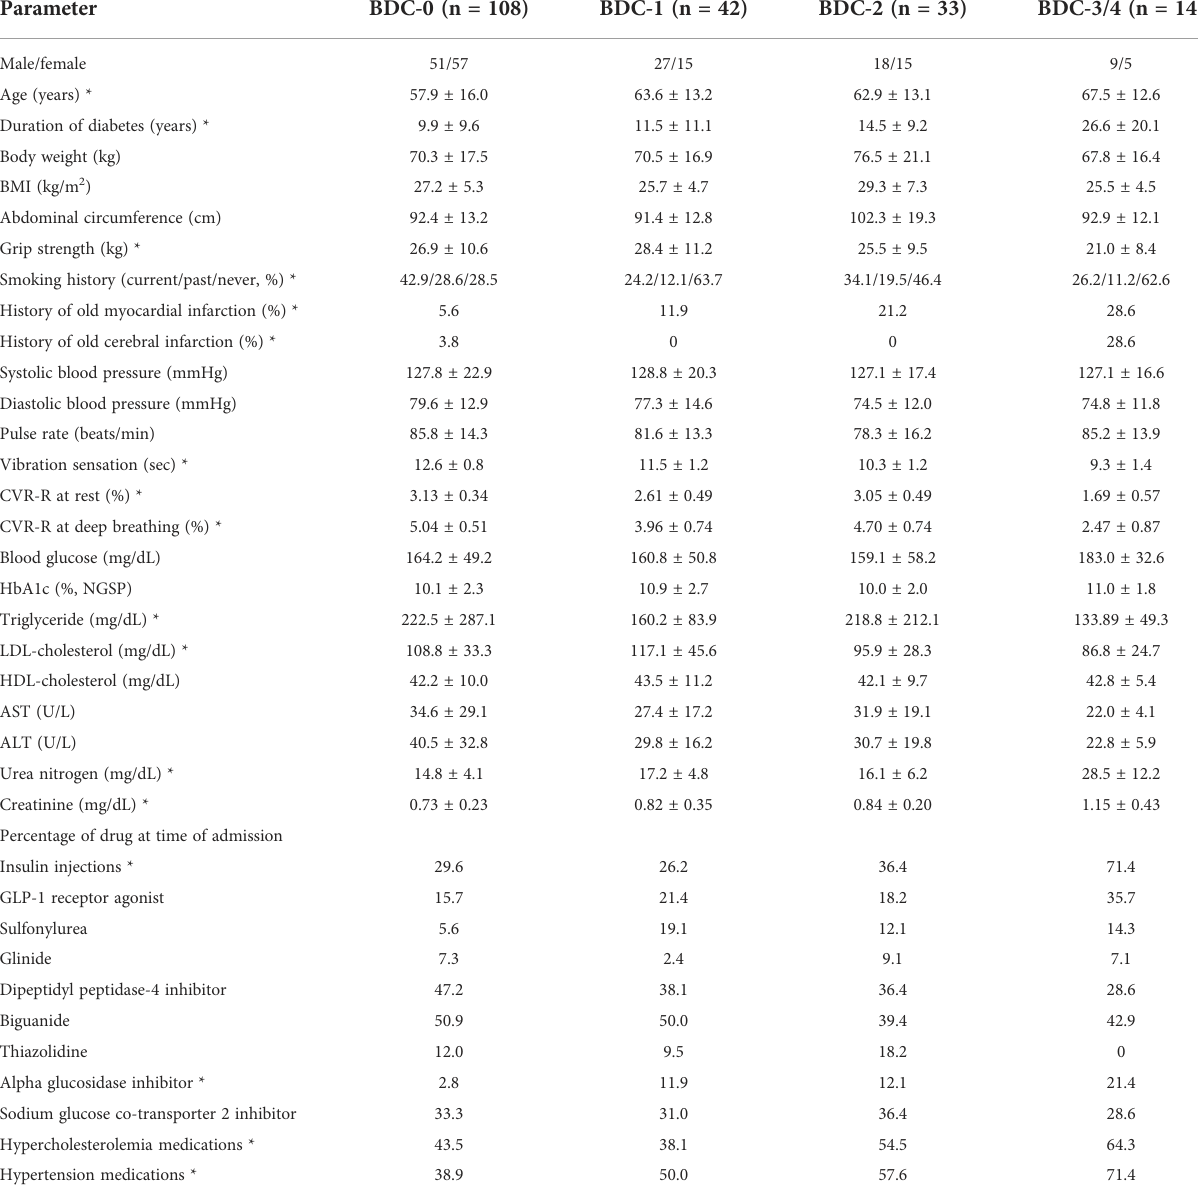
TABLE 1 Comparison of various parameters among patients grouped with Baba ’ s diabetic neuropathy classi fi cation (BDC).